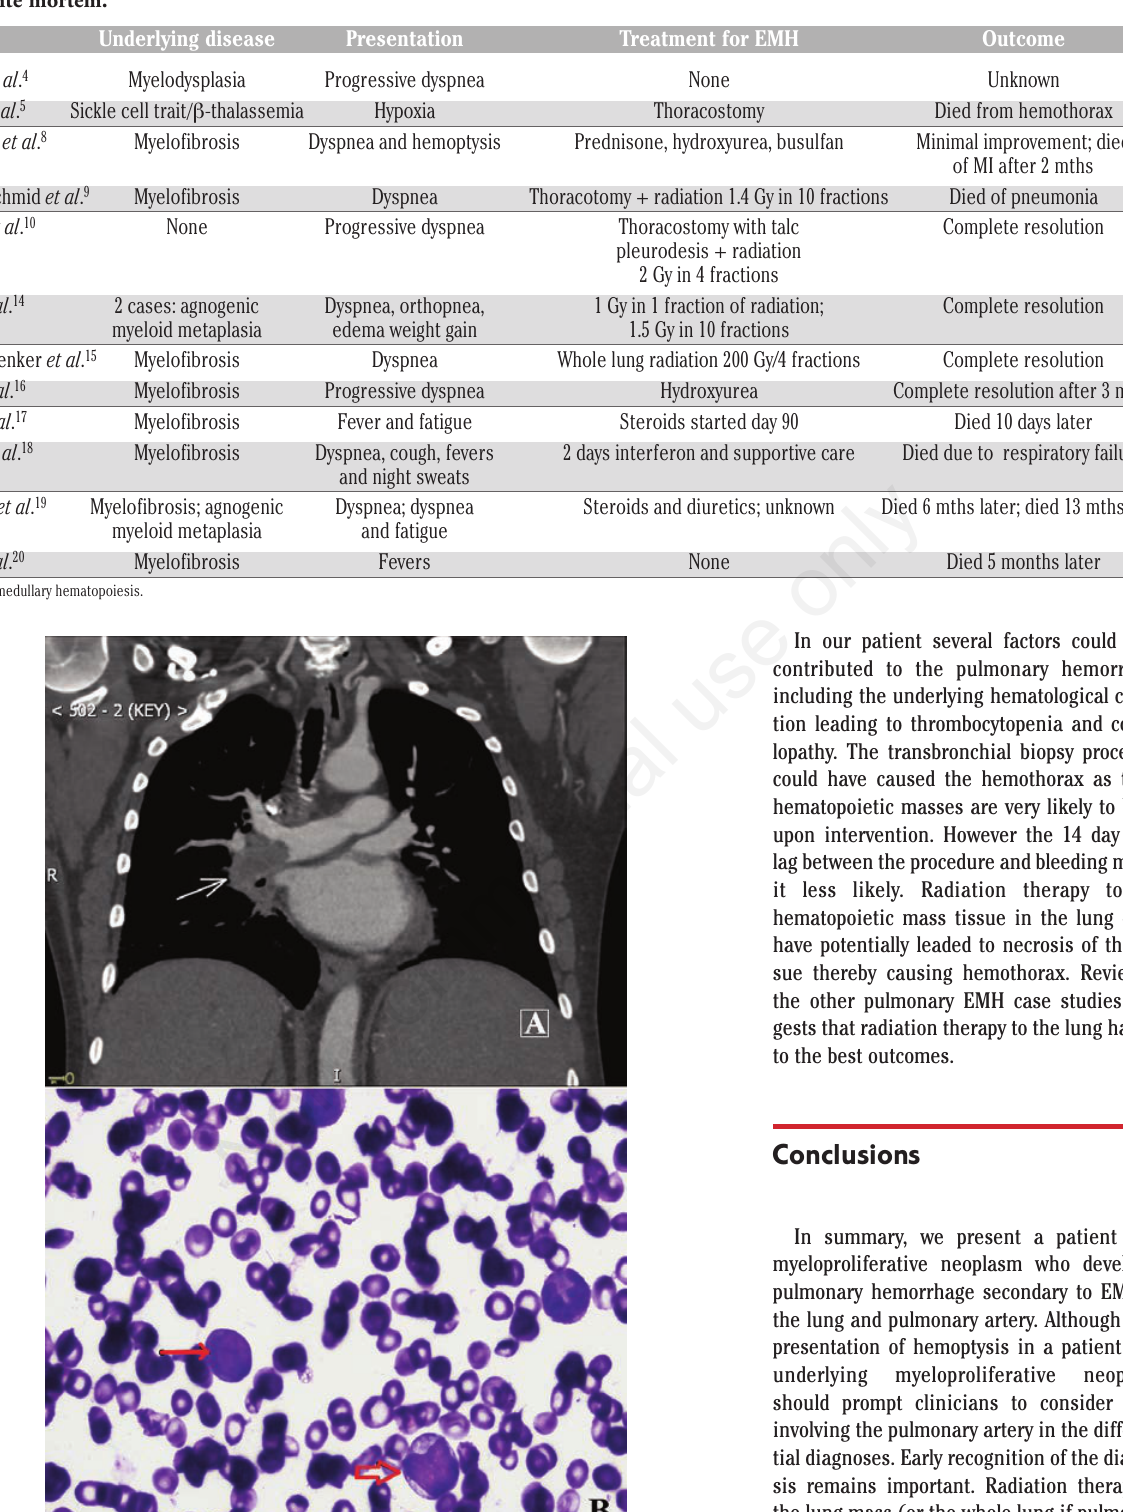
Table 1. Reported cases of patients with underlying myeloproliferative disease presenting with pulmonary involvement by extramedullary hematopoiesis, respective interventions and their outcomes. Diagnosis of pulmonary extramedullary hematopoiesis made ante mortem.